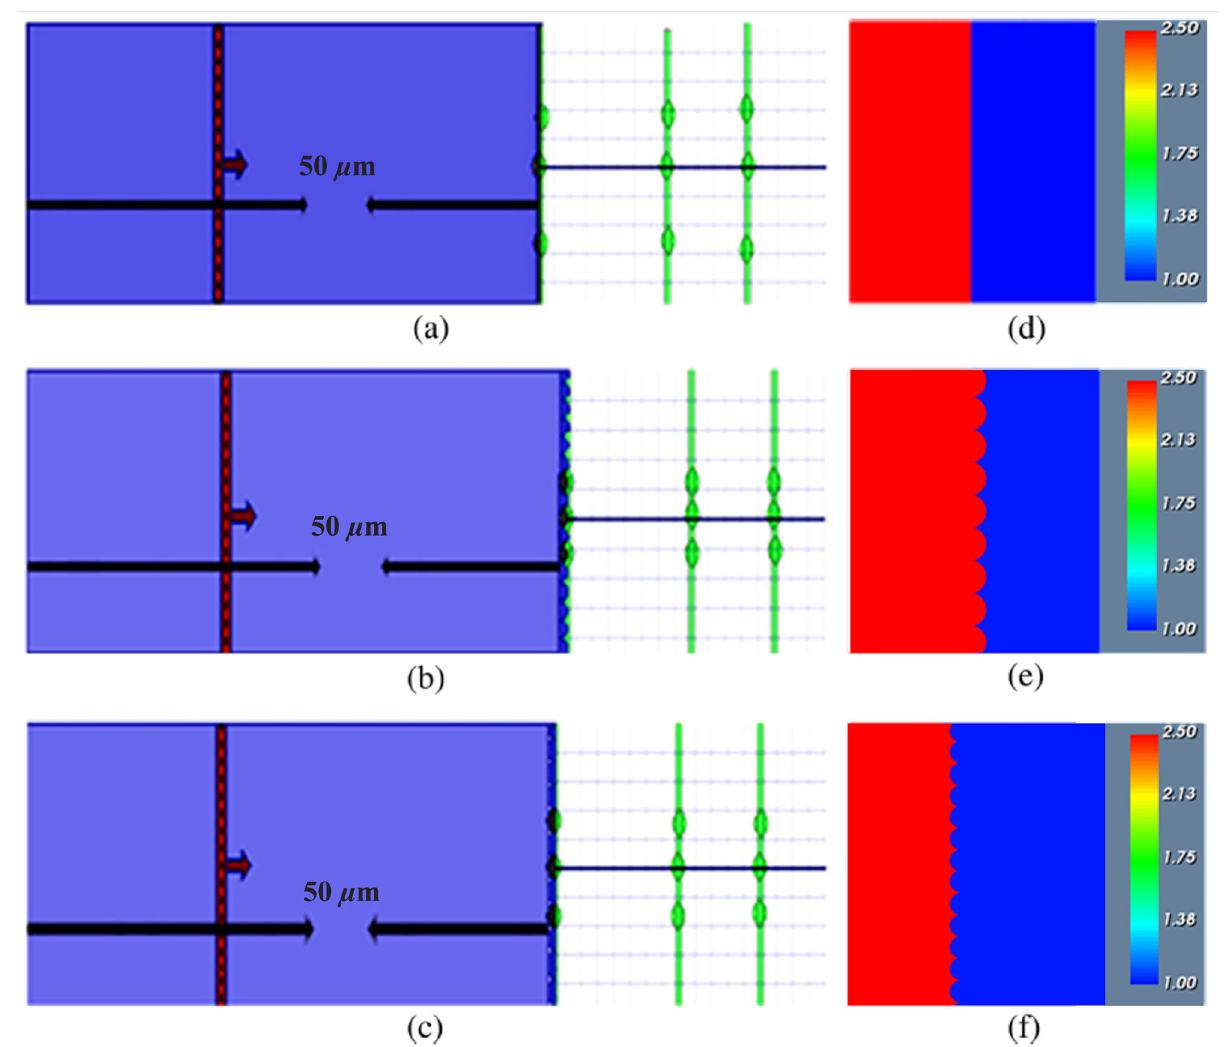
Fig 4. (a)-(c) 2D layout presentation and (d)-(f) RIP of different kinds of OLEDs designs: (a), (d) Basic OLED model; (b), (e) Elliptical planoconvex MLA incorporated OLED; (c), (f) Spherical planoconcave MLA incorporated